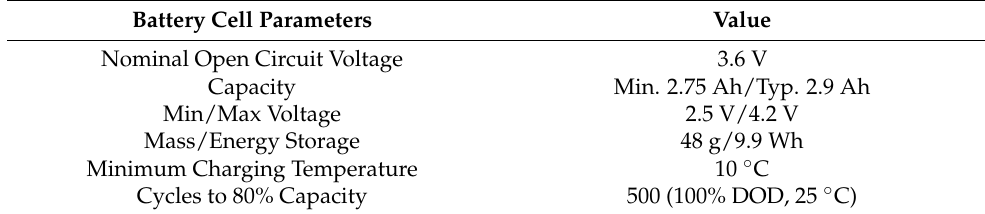
Table 1. Panasonic 18,650 pf cell